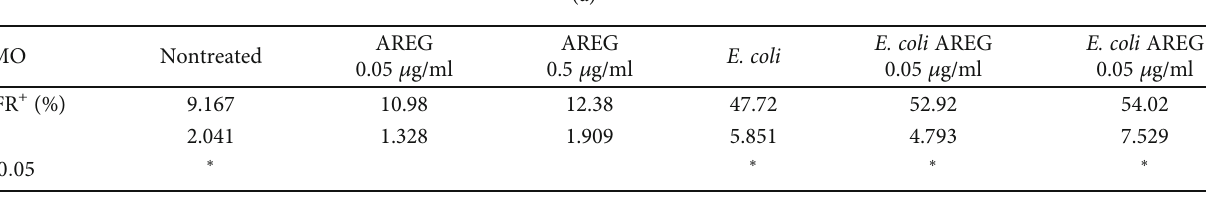
Table 1: Increase of EGFR-expressing monocytes in response to infection. PBMO (a) and CBMO (b) were screened for EGFR expression under indicated conditions. E. coli infections but not addition of AREG increased the population of EGFR-expressing monocytes ( ∗ p < 0 : 05